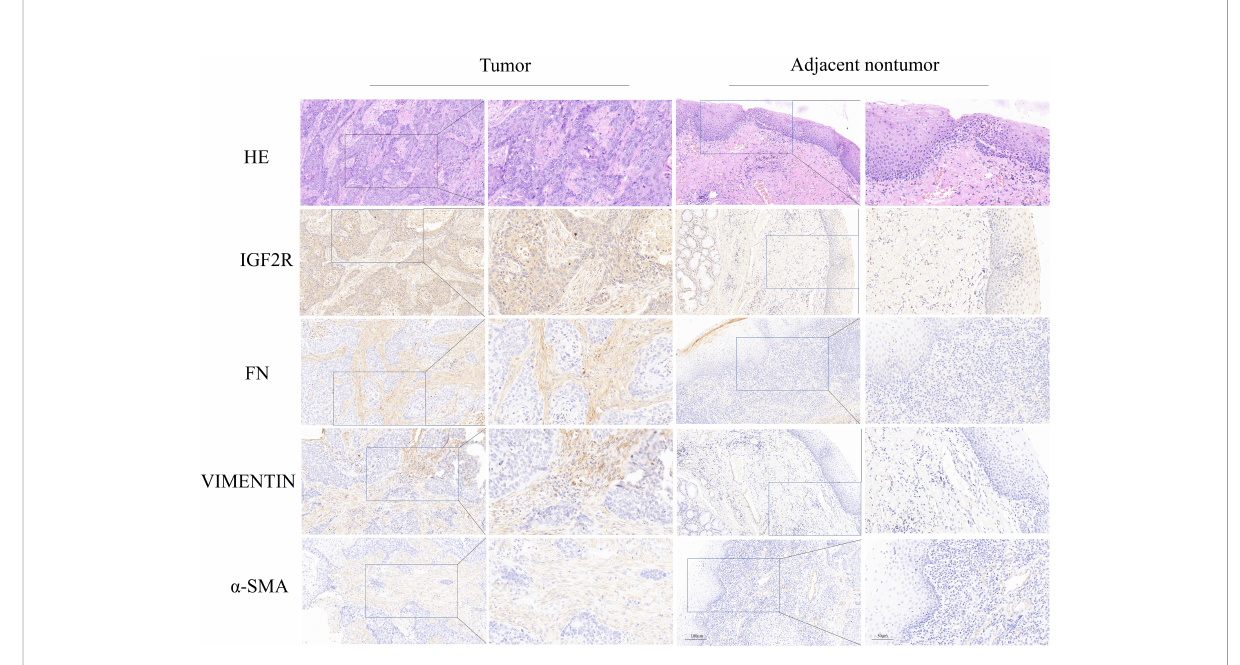
FIGURE 5 Immunohistochemical expression of IGF2R, FN, Vimentin, and SMA in LC and normal